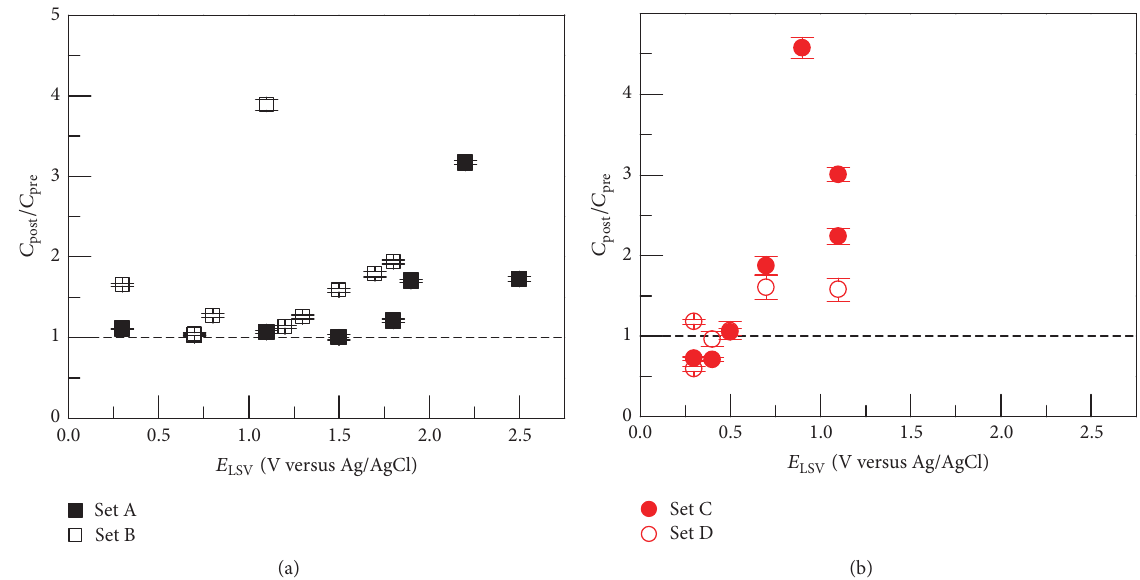
Figure 6: Capacitance ratios, 𝐶 post /𝐶 pre , for (a) the samples in Sets A and B and (b) the samples in Sets C and D as a function of 𝐸 LSV . The dotted lines correspond to ratios equal to 1, indicating no change in capacitance.